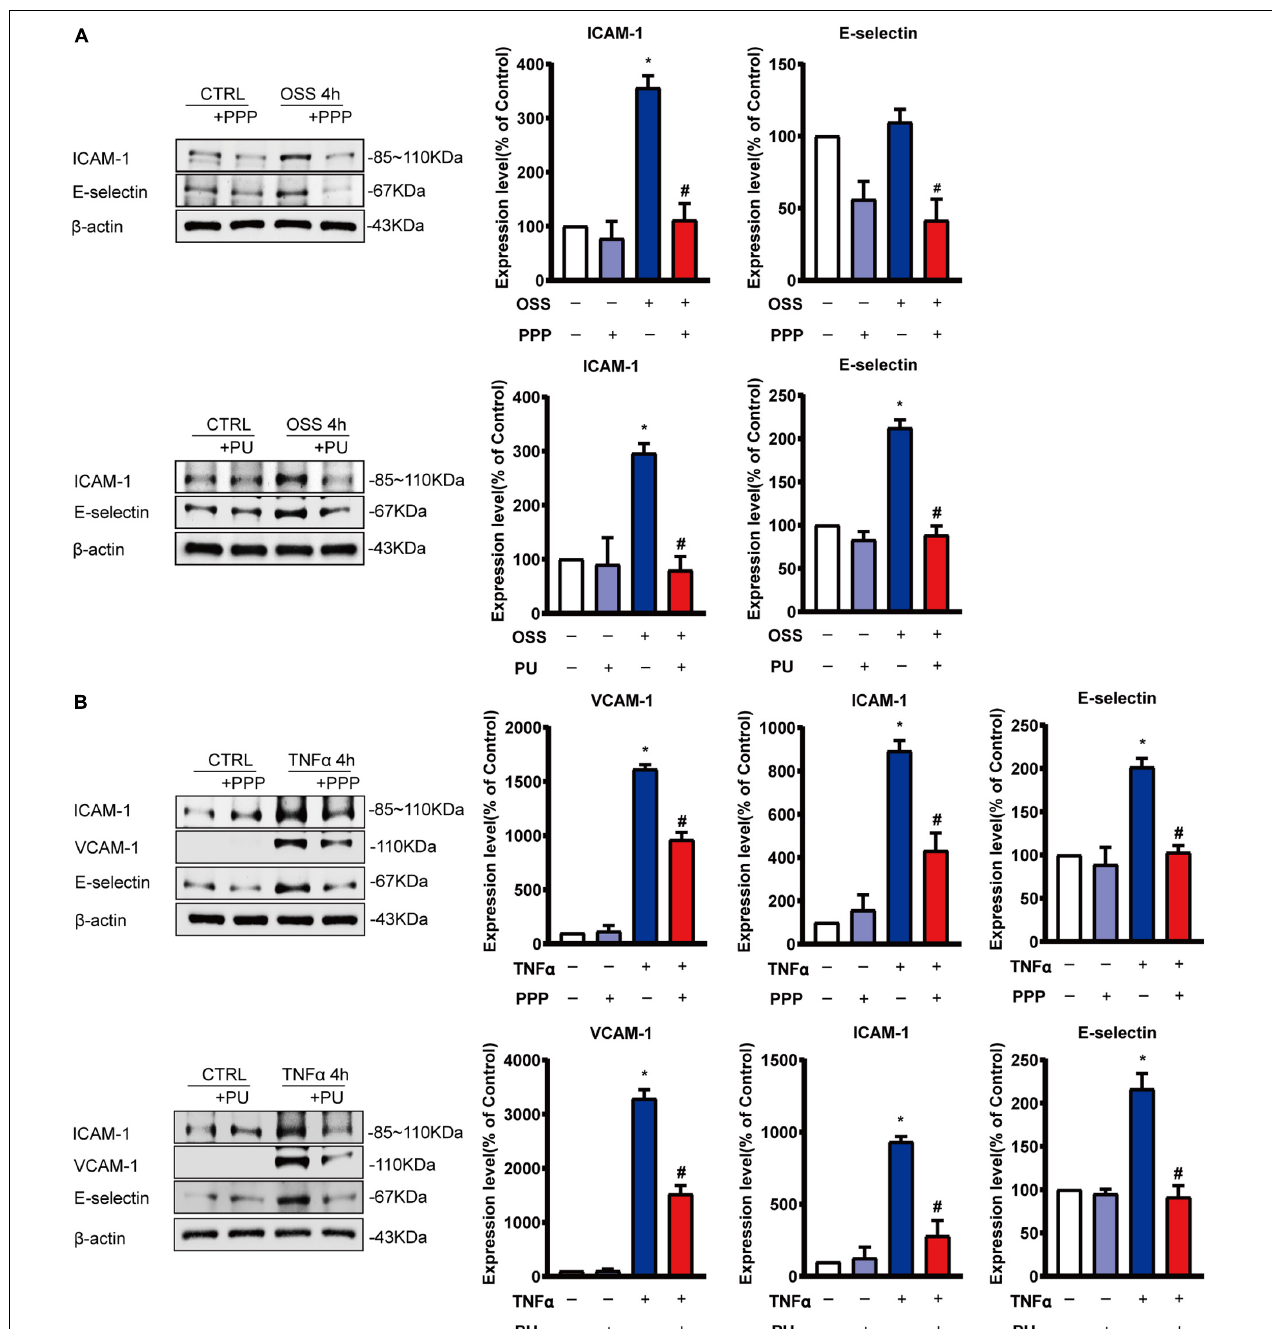
FIGURE 6 | PPP and PU inhibit pro-inflammatory responses of ECs induced by OSS or TNF- α . (A,B) Western blot analysis and quantitative results of the effects of PPP and PU on OSS— (A) or TNF- α (B) —induced pro-inflammatory responses of ECs. Blot is a representative of five independent experiments. * P < 0.05 vs. Vehicle, # P < 0.05 vs.